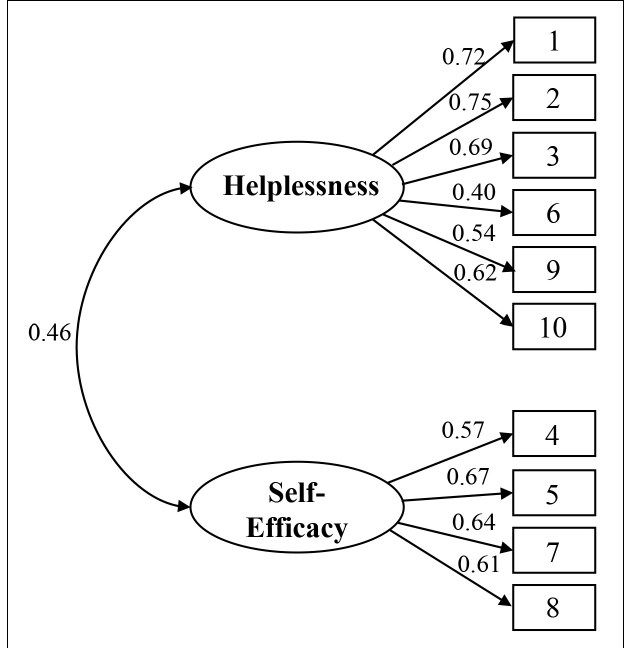
FIGURE 1 | Standardized factor loadings for the two-factor model of the 10-item Perceived Stress Scale (PSS-10) ( N = 1,574).